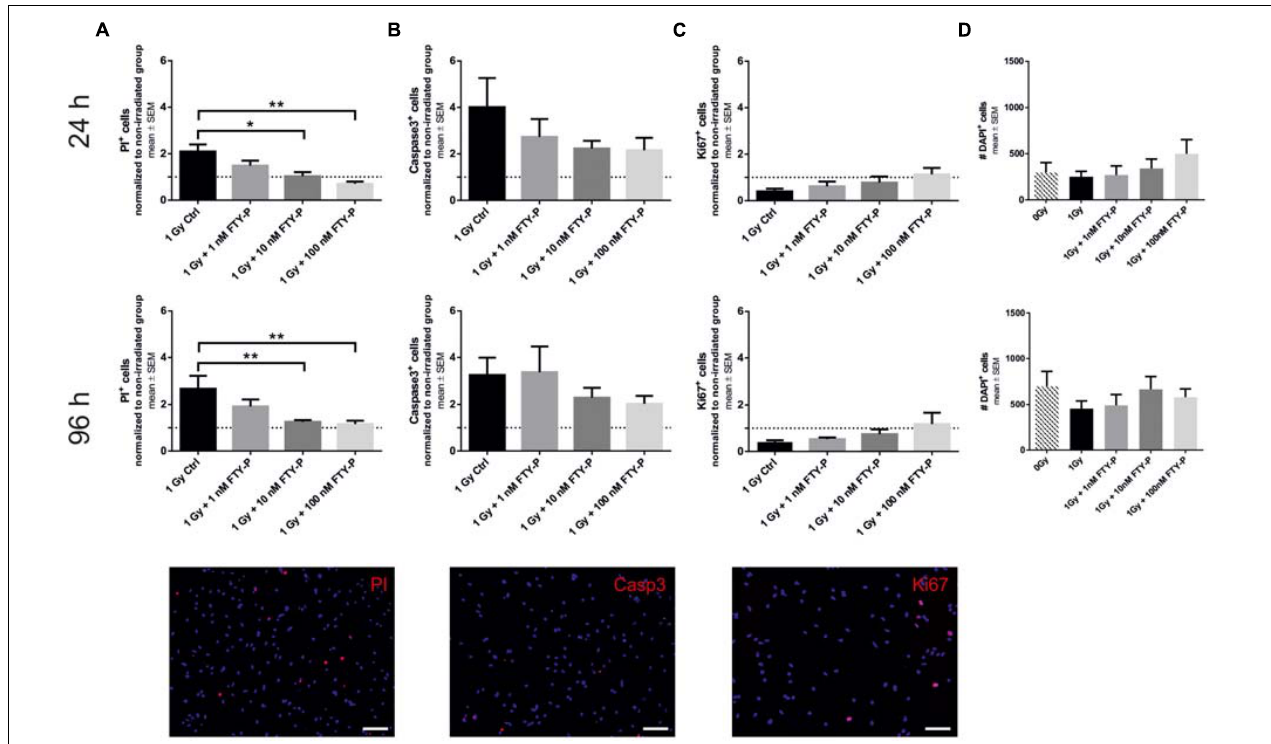
FIGURE 2 | Cell death and proliferation of FTY720P-treated neuronal stem cells. Cell death and proliferation was analyzed 24 and 96 h after irradiation by immunocytochemistry with propidium iodide (PI) ( A ; 24 h: n = 6, 96 h: n = 6), active caspase-3 ( B ; 24 h: n = 5, 96 h: n = 6), Ki67 ( C ; 24 h: n = 5, 96 h: n = 6). (D) Total number of DAPI positive cells was calculated for both time points ( n = 6). Results are presented as mean ± SEM. Irradiated groups were normalized to sham irradiated counterparts. ∗ p < 0.05; ∗∗ p < 0.01 (one-way ANOVA: B 96 h, D 96 h; Kruskal–Wallis: A,B 24 h, C,D 24 h). Representative cells examples of each staining are shown at the bottom, scale = 100 µ